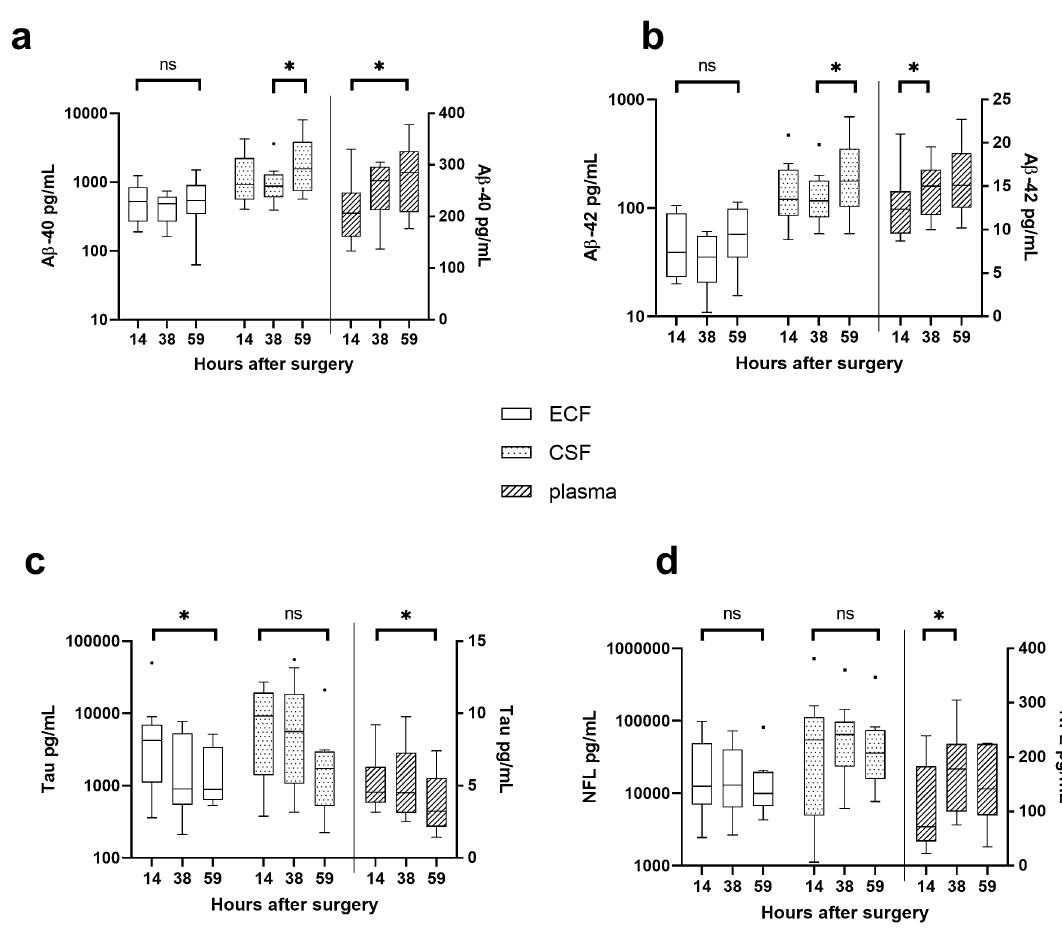
Figure 3. Dynamic changes in Aβ, tau and NF-L biomarkers in the different fluid compartments over time. In extracellular fluid (ECF), median levels of Aβ-40, Aβ42 or NF-L did not change over time, whereas the tau levels significantly decreased over time. In cerebrospinal fluid (CSF), Aβ40 and Aβ42 levels increased, whereas there was no significant difference in the levels of tau or NF-L over time. In plasma, levels of Aβ40 and Aβ42 increased over time, as did the levels of tau and NF-L. Tukey box plot. Note that, for visual clarity, ECF and CSF levels are displayed on the left Y-axis which is logarithmic whereas plasma levels are displayed on the right Y-axis which is linear. Ns = not significant; * = p <